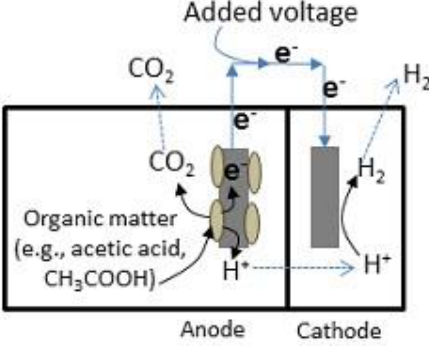
Figure 2. Microbial electrolysis cells [54].